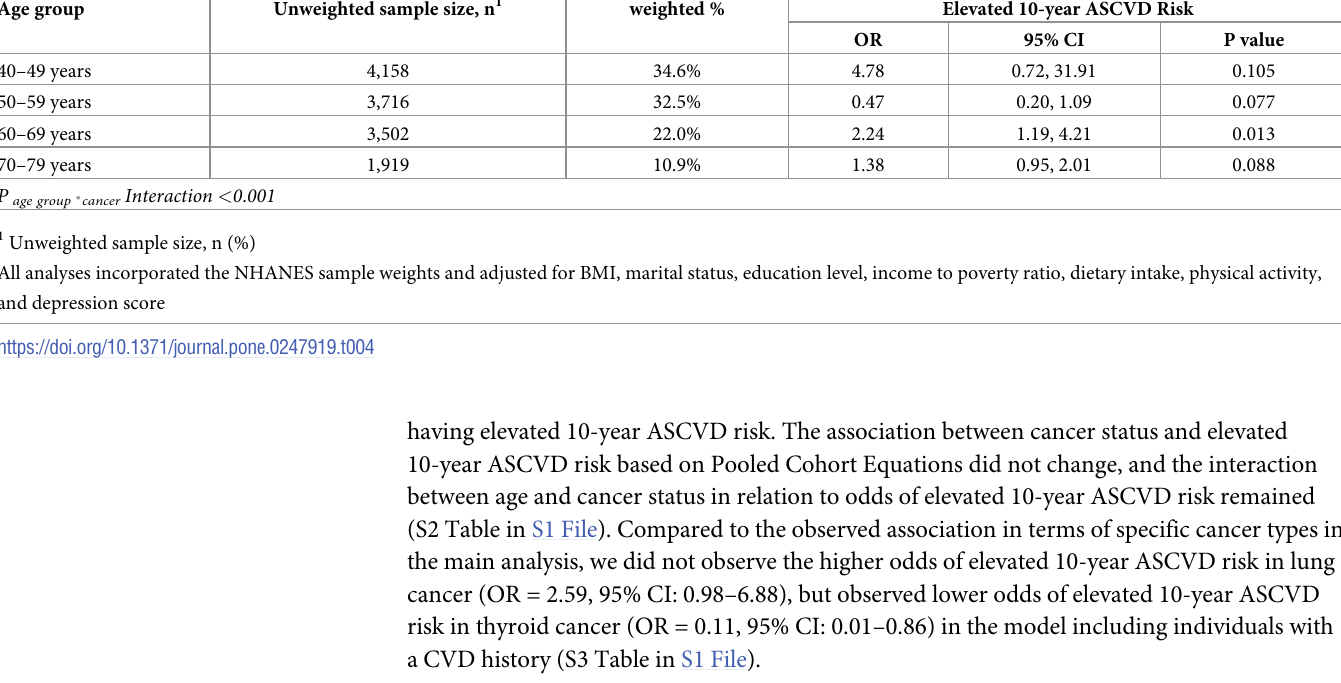
Table 4. Odds ratios (ORs) and 95% confidence intervals (CIs) for associations between cancer status and elevated vs. low 10-year ASCVD risk based on Pooled Cohort Equations according to age group, 2007–2016 NHANES. Age group